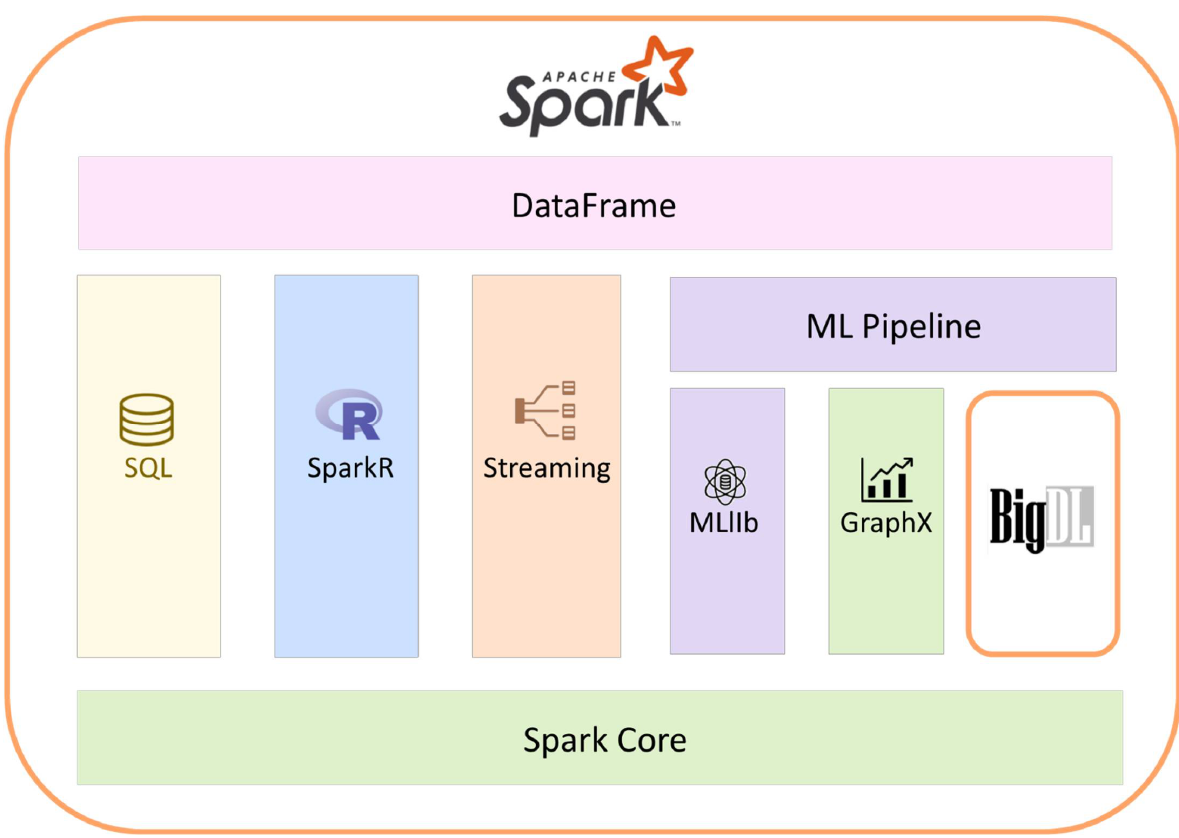
Figure 2. Apache Spark and its relation to BigDL library for deep learning.